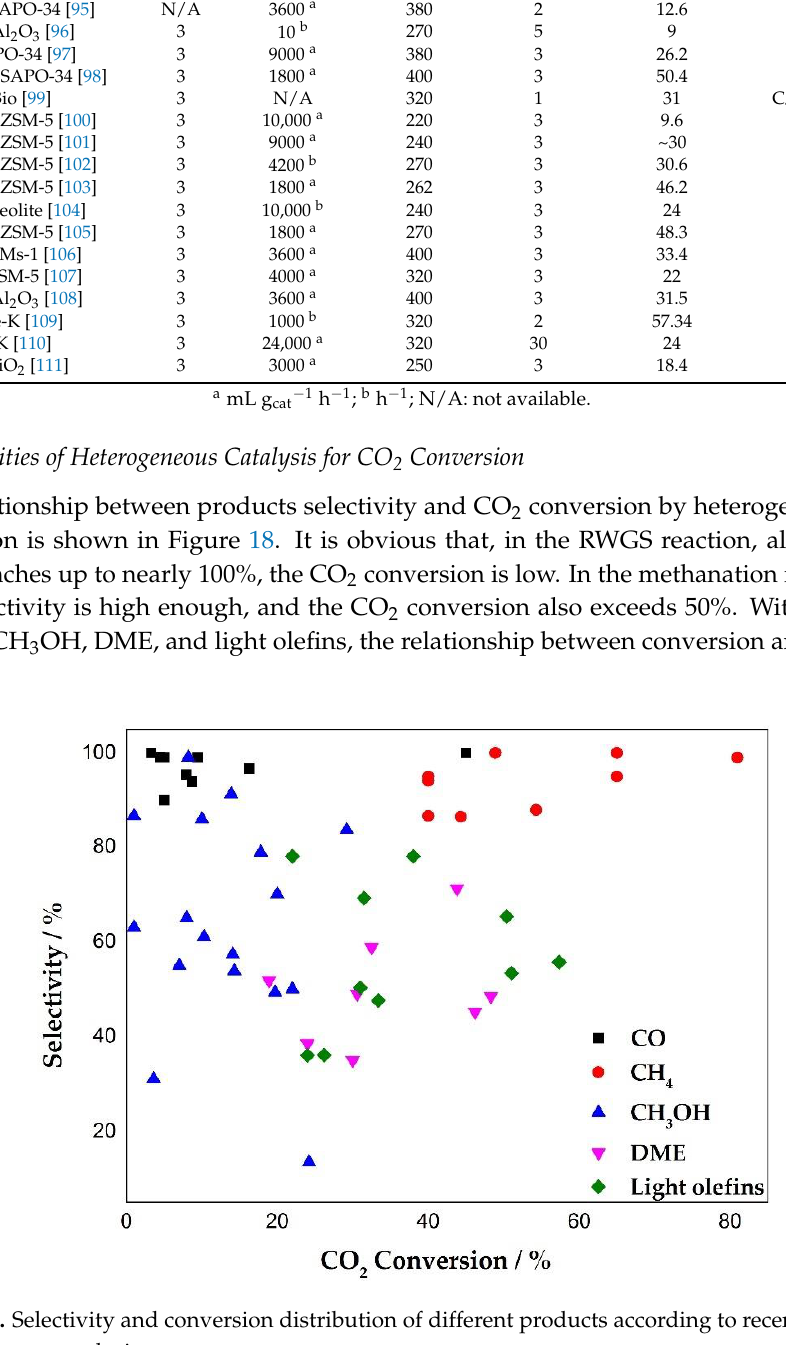
Figure 18. Selectivity and conversion distribution of different products according to recent reports in heterogeneous heterogeneous catalysis.